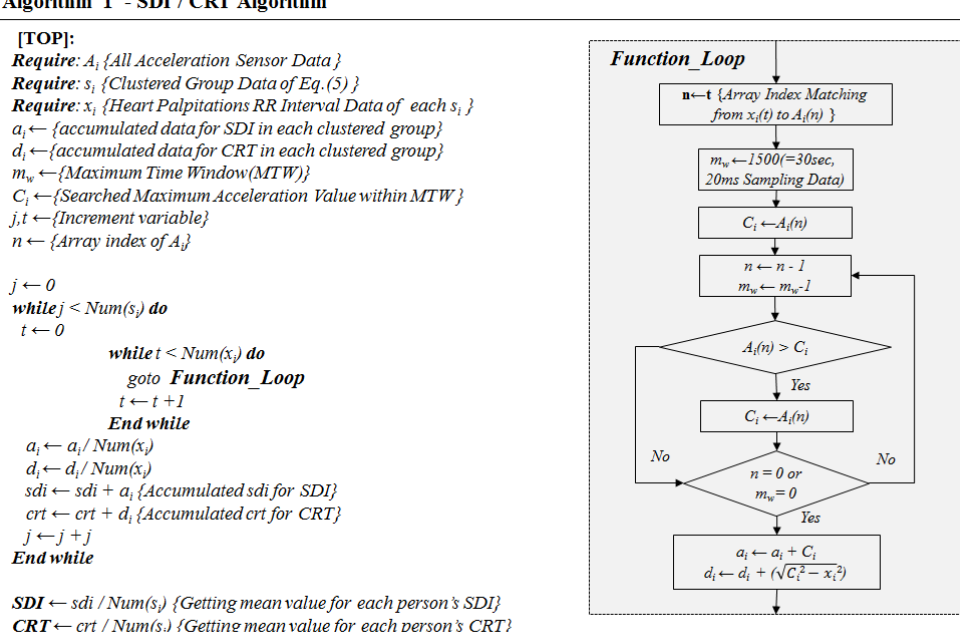
Figure 5. Main algorithm of SDI/CRT.